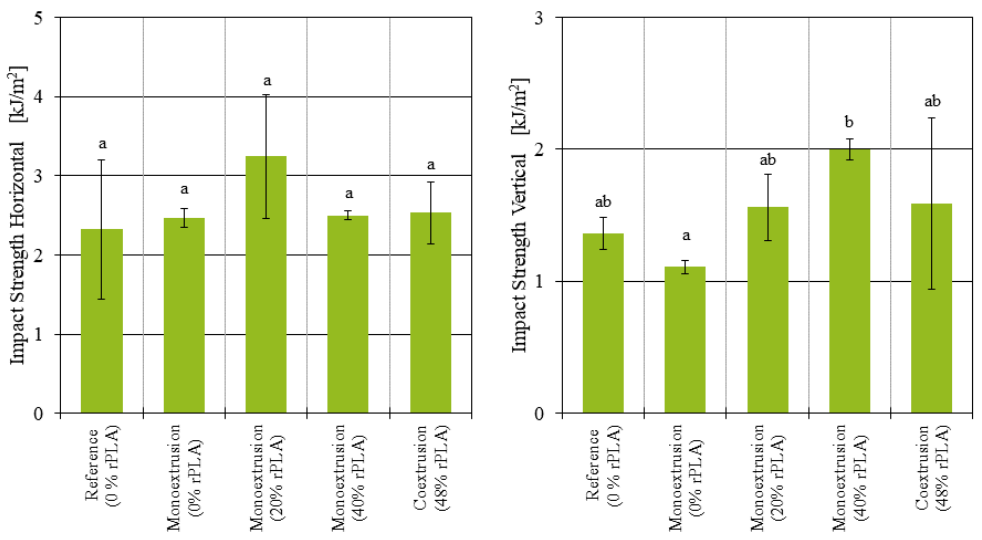
Figure 7. Charpy impact strength of additively manufactured samples manufactured in horizontal and vertical position.